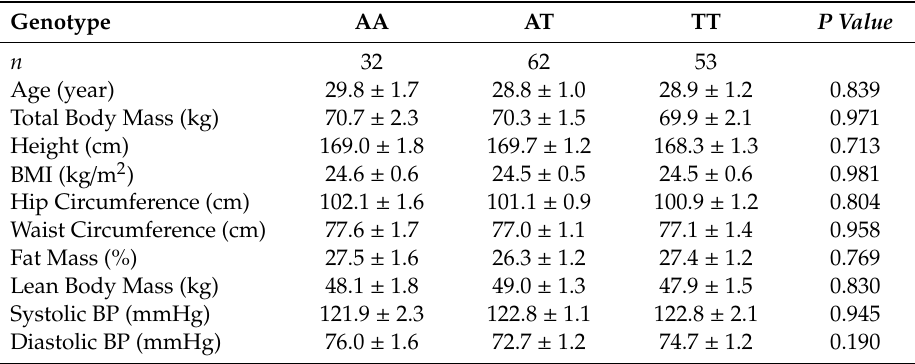
Table 1. Clinical characteristics of the studied cohort based on their fat mass and obesity-associated (FTO) rs9939609 genotype. Values are expressed as mean ±